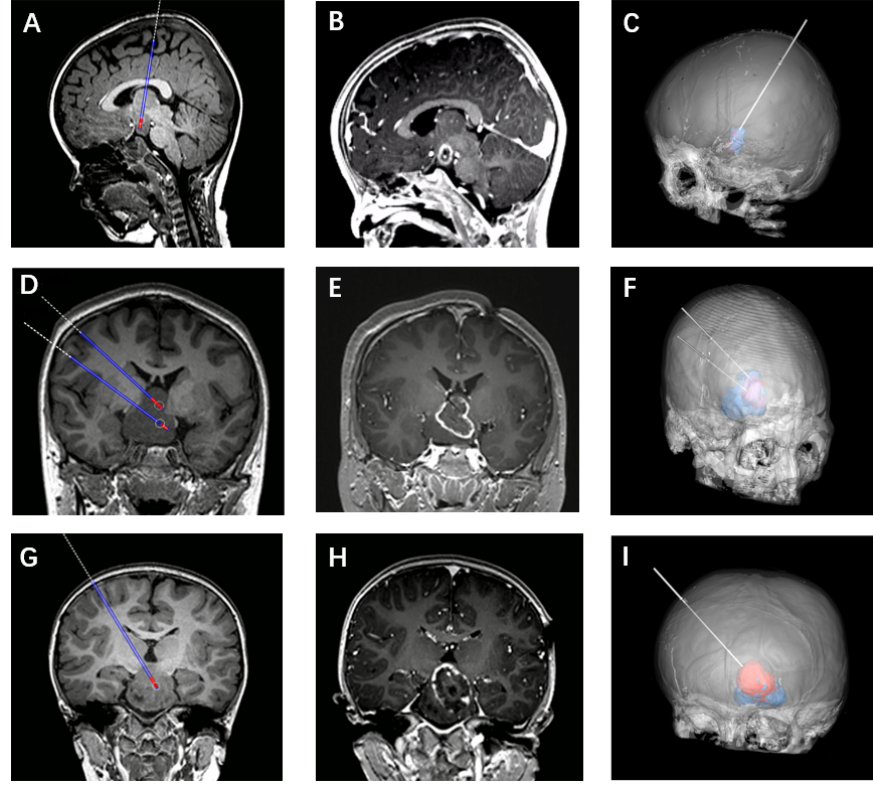
Figure 3. ( A – C ) Showing the posterior approach of laser implantation. ( D – F ) Two laser fibers